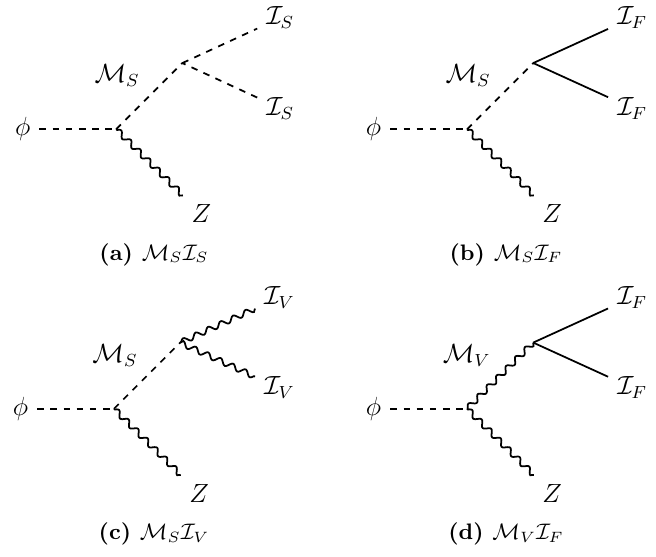
Figure 5. Mono- Z + E miss